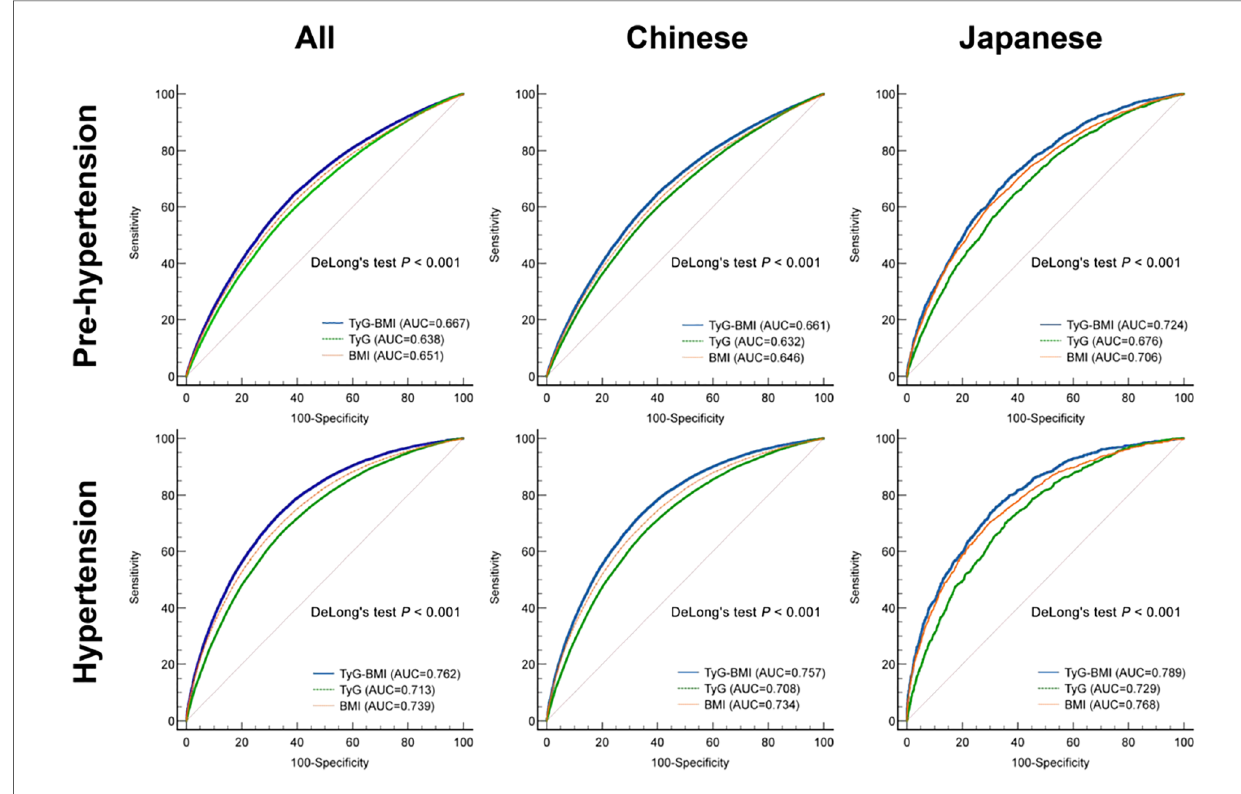
FIGURE 3 ROC curve analysis of TyG-BMI, TyG and